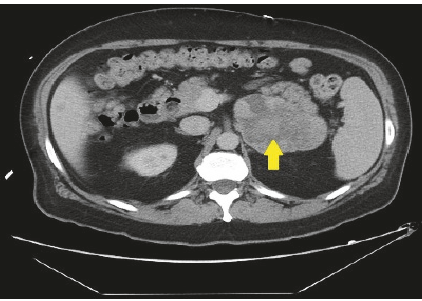
Figure 3: Two hypoechoic round lesions in the left lobe of the liver.